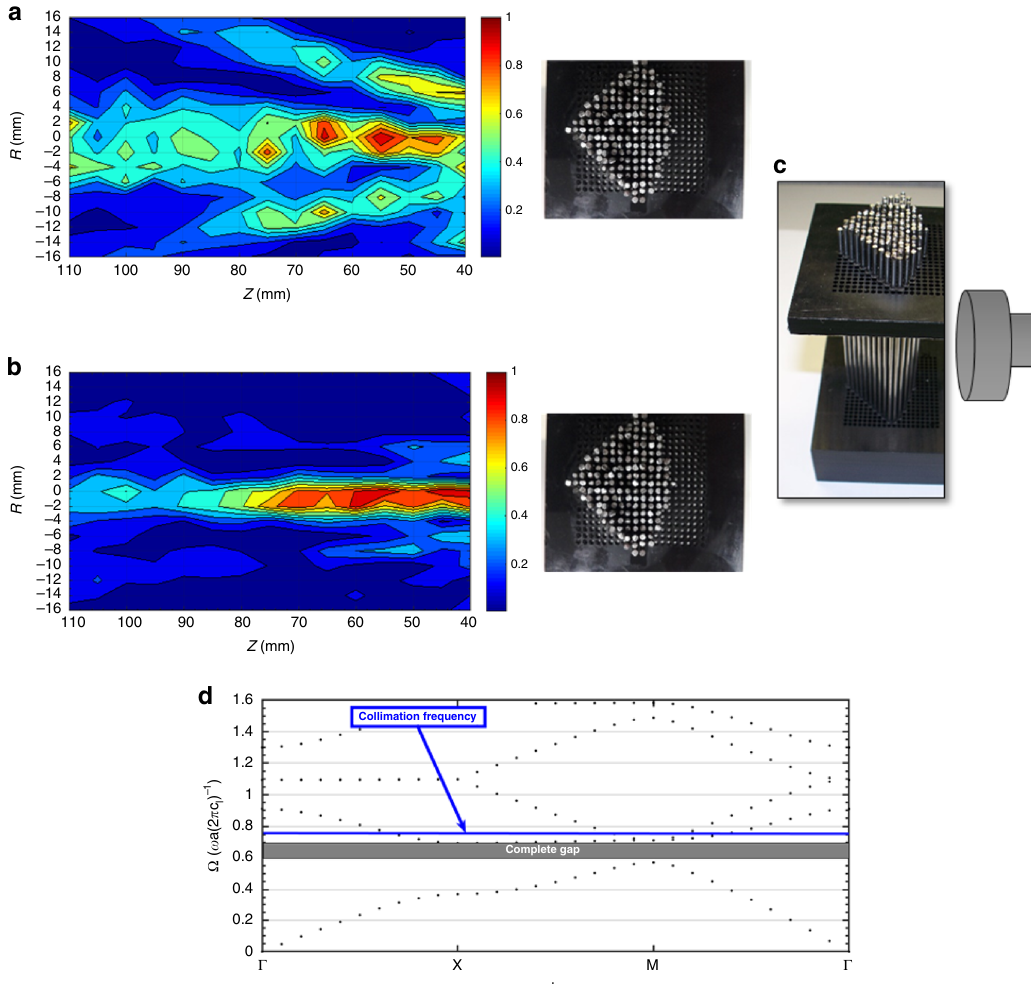
Fig. 1 Metamaterial lens with sound fi eld at collimation and non-collimation frequencies. Experimentally measured spatial sound fi eld of metamaterial lens at 527 kHz demonstrating beam divergence ( a ) and 576 kHz demonstrating collimation ( b ). c Image of 2D phononic crystal metamaterial lens used for examining enhanced lateral resolution with the setup for the emitter. d The collimation frequency occurs above the fi rst complete gap where dk variable and non-positive for some wavevectors, indicative of metamaterial